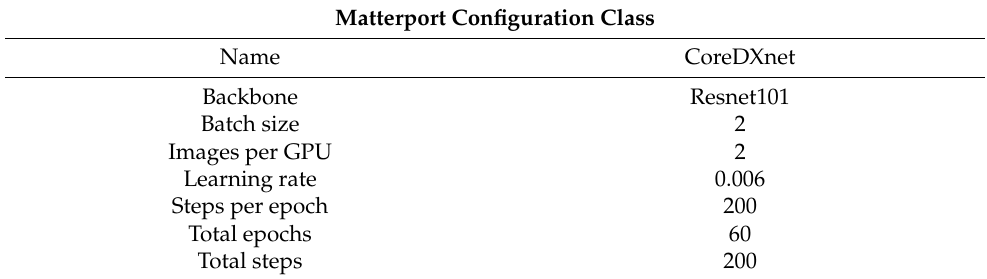
Table 2. Final parameters of the model.